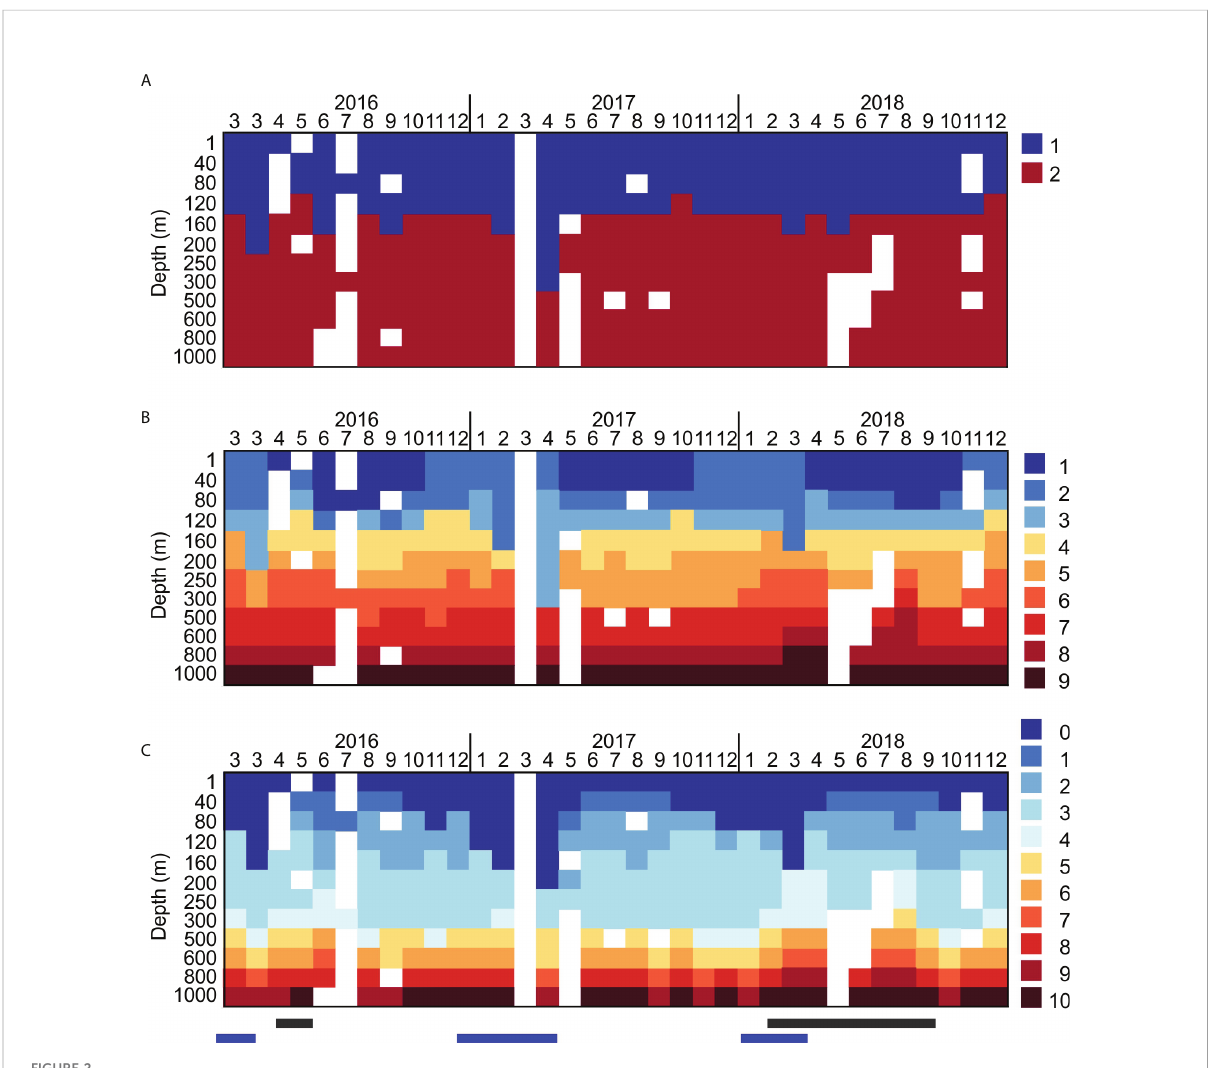
FIGURE 2 Assignment for each sampled depth, at each month, to the community-composition based on non-hierarchical clusters for (A) K =2 (upper panel) and (B) K =9 (middle panel). Numbers are indicative of months at the top of each panel. K =2 separates the epipelagic and the mesopelagic, meanwhile K =9 re fl ects the epipelagic seasonality and depth-strati fi cation. The lower panel (C) shows the assignment of each sample to the 11 hydrographic layers de fi ned by Curry et al. (see text, and Table 1). Blue bars correspond to deep mixing events, black bars to uplift of the deeper layers due to the passage of